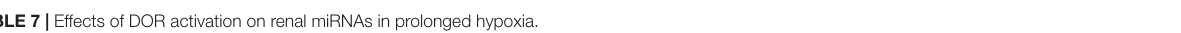
TABLE 7 | Effects of DOR activation on renal miRNAs in prolonged hypoxia.